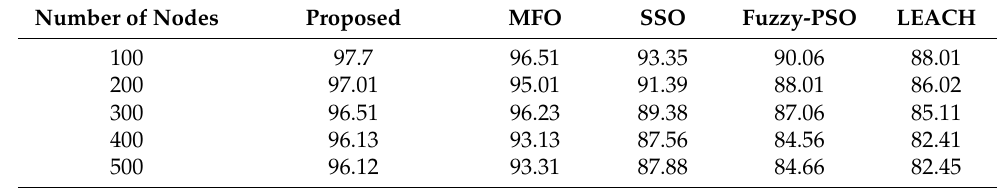
Number of Nodes